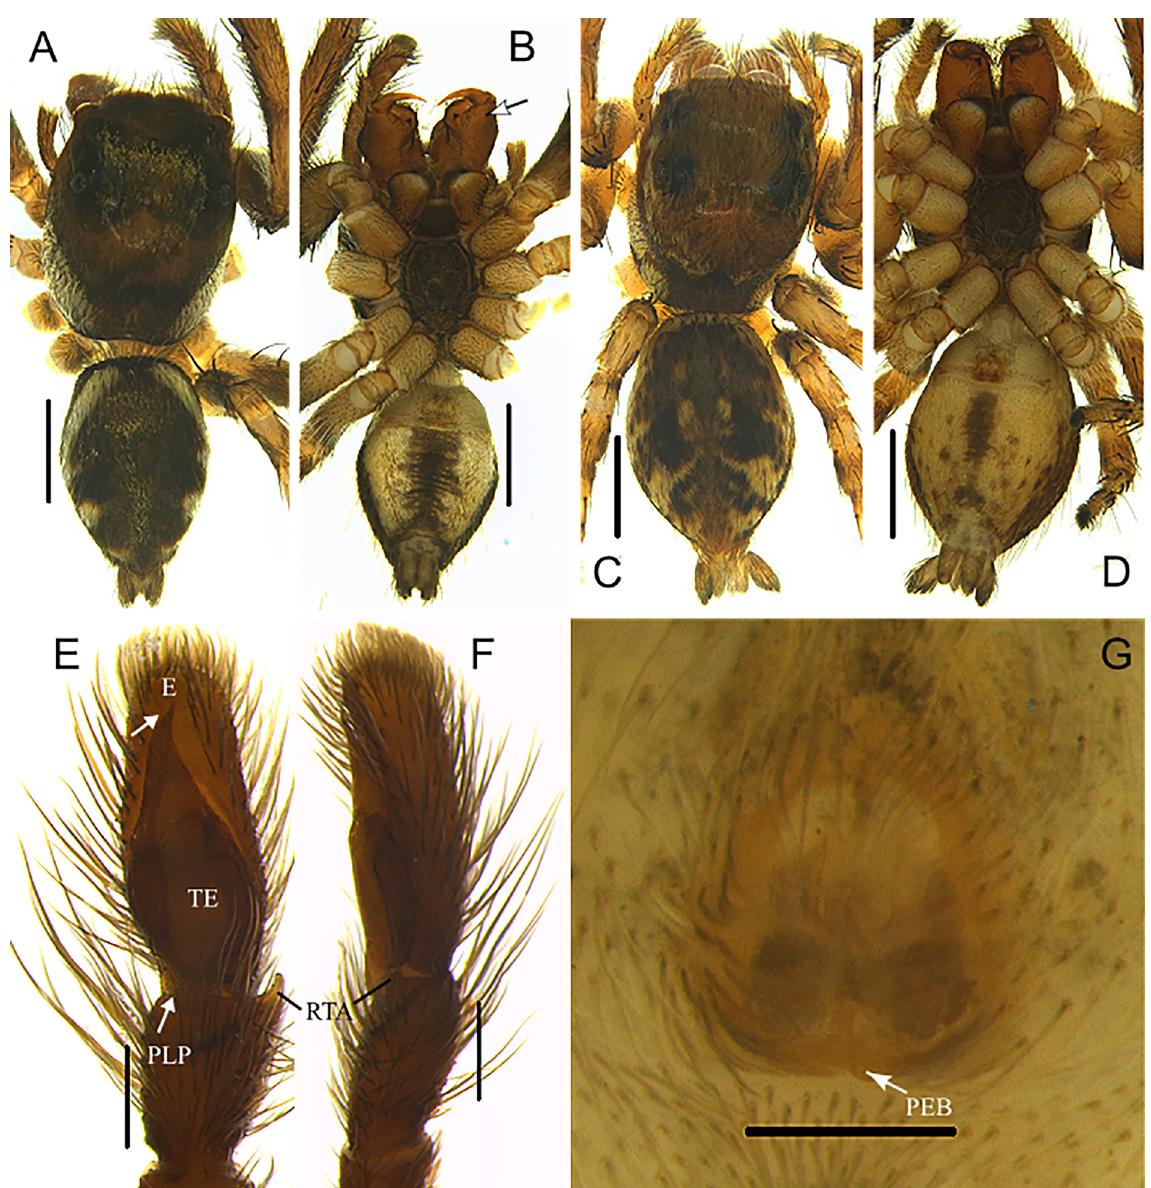
Fig 13. Carrhotus taprobanicus Simon, 1902. A–B . Male habitus. A . Dorsal view. B . Ventral view. C–D . Female habitus. C . Dorsal view. D . Ventral view. E–F . Palp. E . Ventral view. F . Retrolateral view. G . Epigynum, ventral view. Abbreviations: E = embolus; PEB = posterior epigynal border; PLP = posterior lateral protrusion; RTA = retrolateral tibial apophysis; TE = tegulum. Scale bars: A–D = 2